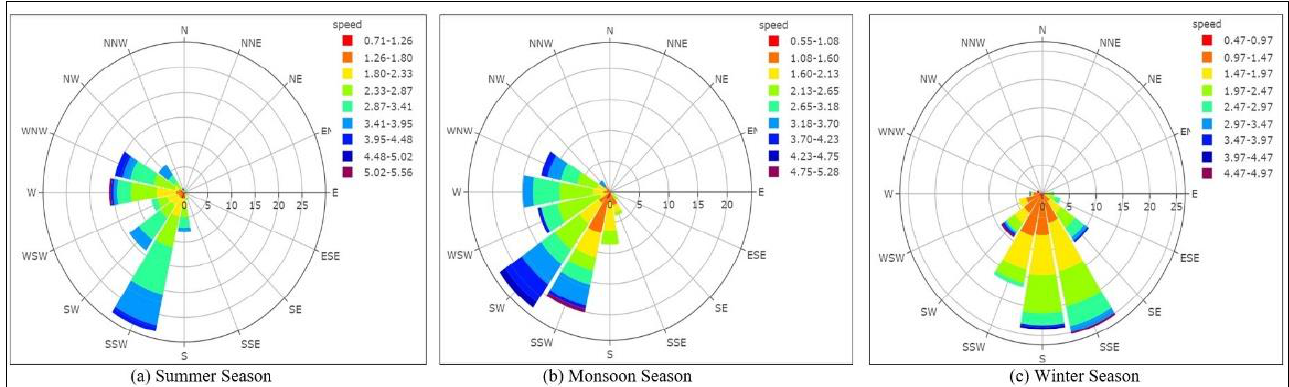
Figure 3. Wind rose diagram for summer, monsoon and winter seasons.